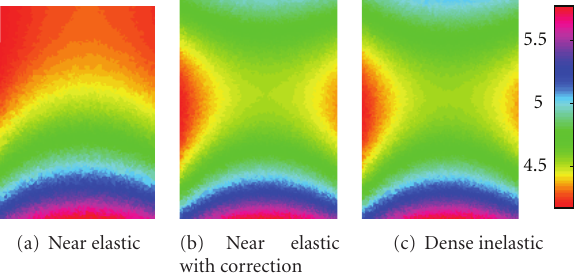
Figure 5: Comparison of granular temperature variation in two- dimensional cell for (a) near elastic model (b) near elastic model with modification, and (c) dense inelastic model for V ∗ = 3 . 0.